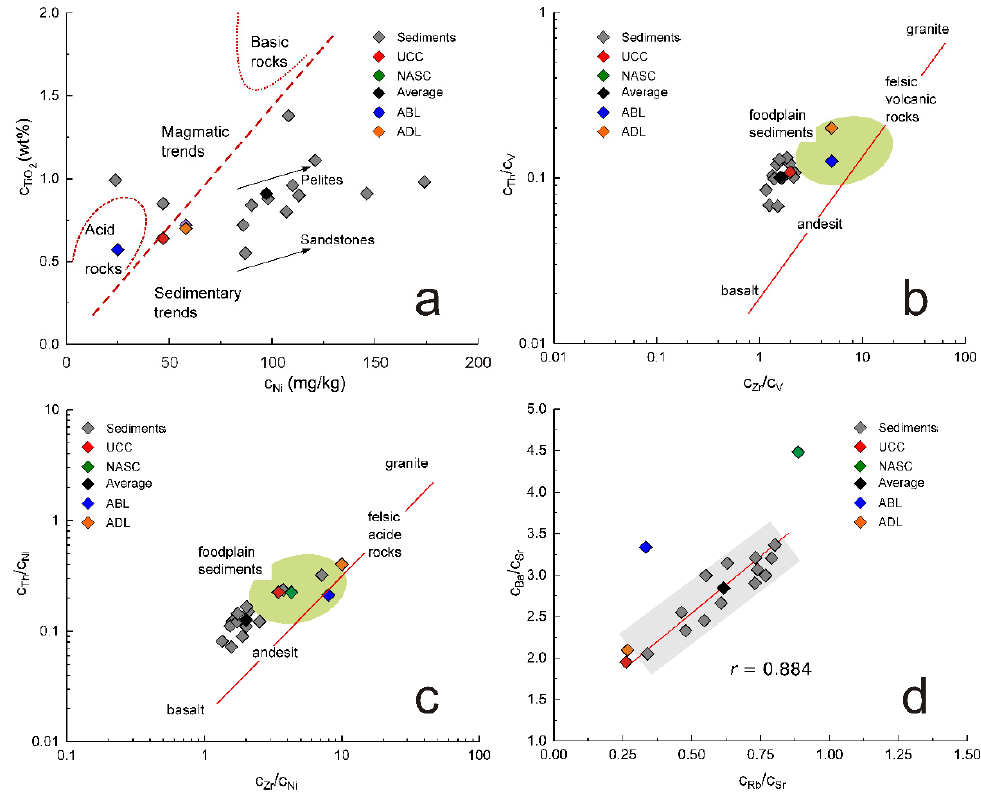
Figure 5. The discriminating biplots TiO 2 vs. Ni ( a ), Th/V vs. Zr/V ( b ), Th/Ni vs. Zr/Ni ( c ), and Ba/Sr vs. Rb/Sr ( d ) indicate that the investigated sediments are similar to UCC [22], NASC [23], ABL [24], and ADL [25].